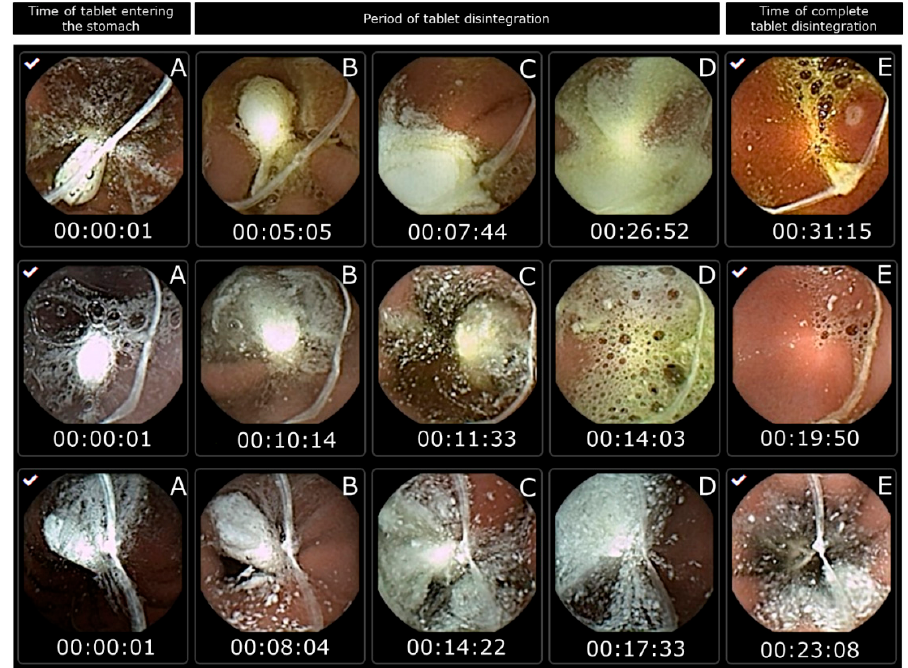
Figure 4. Images from capsule endoscopy to visualize Panadol disintegration time in each beagle dog after oral administration (n = 3). The time of the tablet entering the stomach is set as the start time ( A ). The period of tablet disintegration is while the tablet is still visible ( B , C , D ). The time of complete tablet disintegration is when no residue is seen of the tablet or the tablet is fully fragmented ( E ).